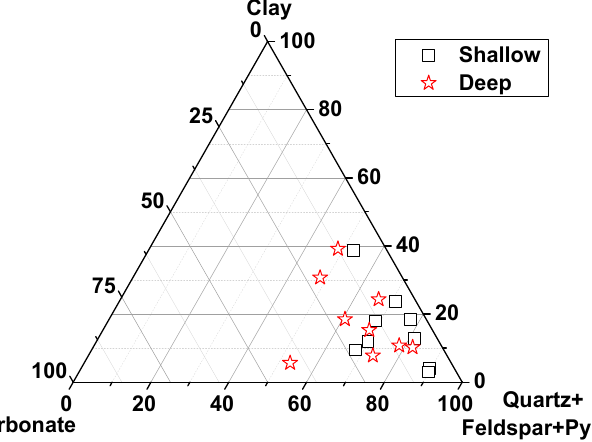
Figure 11. Ternary diagram of mineral composition.